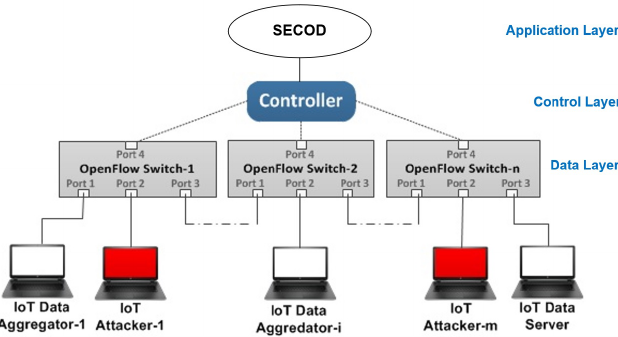
Figure 1. The basic topology of SDN-based IoT architecture under a DDoS